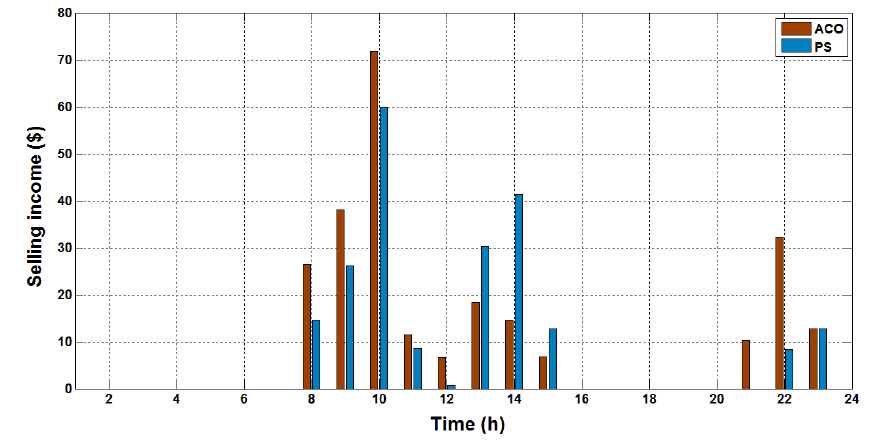
Figure 12. Power selling income comparison.